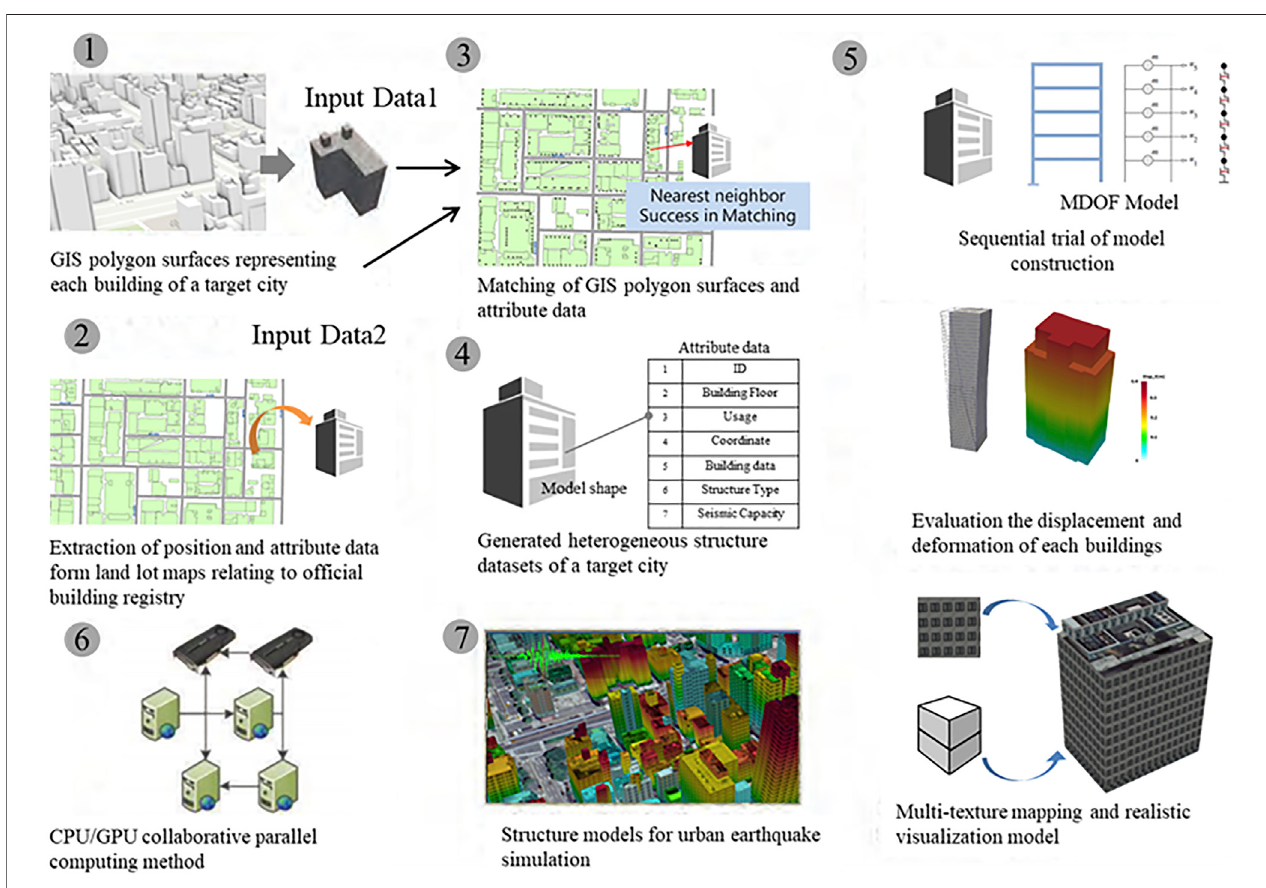
FIGURE 8 | 3D visualization of an earthquake ’ s impact.